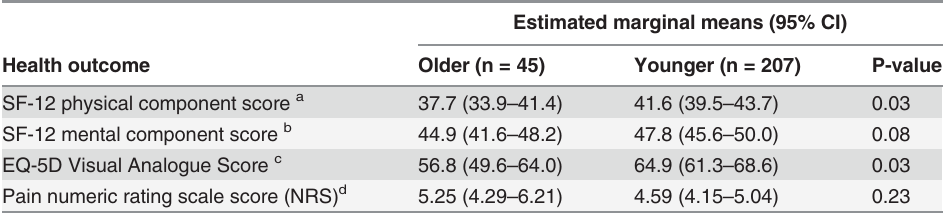
Table 3. Quality of life scores and severity of pain among older ( (cid:1) 65 years) and younger (18 – 64 years) participants 24 months after a mild/ moderate musculoskeletal injury (n =